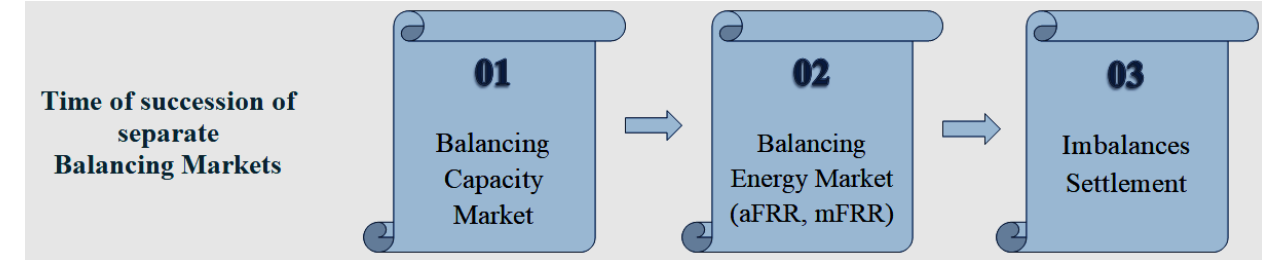
Figure 4. The balancing market structure in Greece [23].